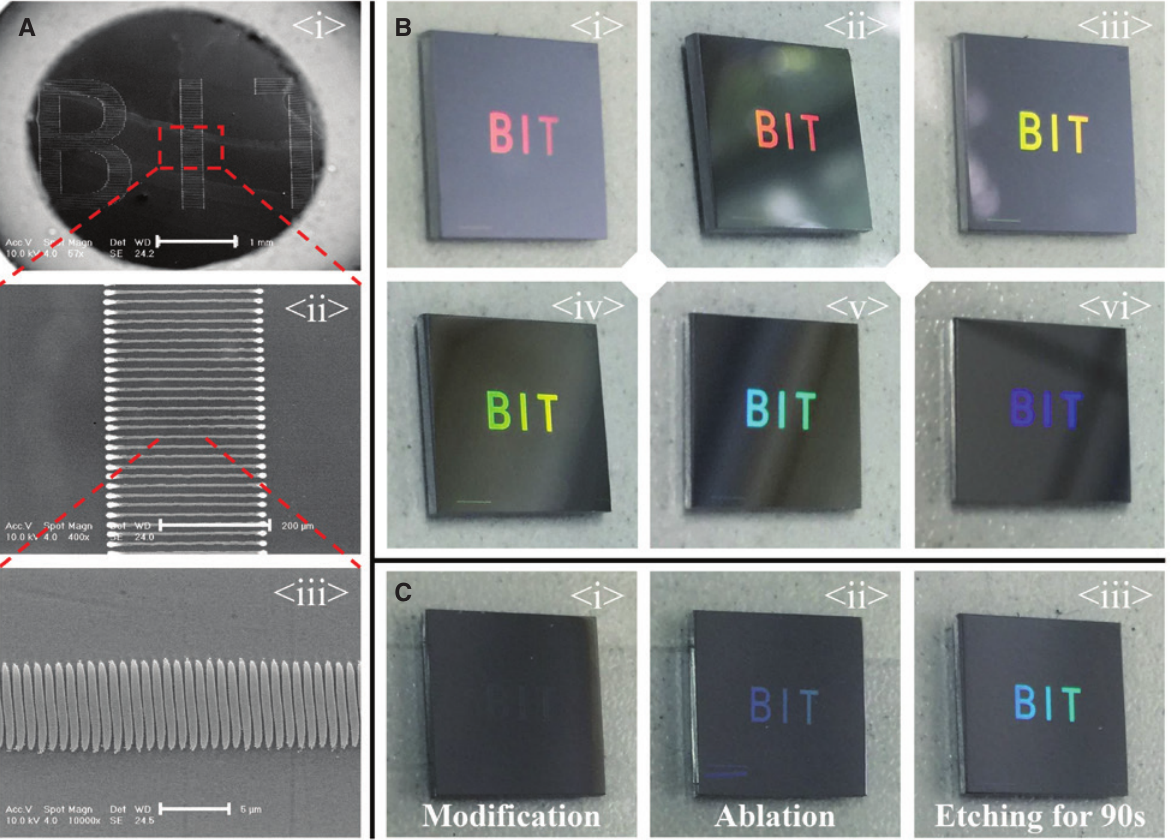
Figure 6: “BIT”-shaped large-area nanograting structures fabricated by chemical etching-assisted femtosecond laser modification, using = 2000 μ m s −1 , and T = 90 s, respectively. F = 167 mJ cm −2 , v scan et (A) SEM micrographs of the fabricated structure. (A < ii > ) and (A < iii > ) are the magnified depictions of (A < i > ). The scales in (A) are 1 mm, 200 μ m, and 5 μ m, respectively. (B) The structural colors of the Si surface with 2D nanograting structures. Gradual changing of the viewing angle leads to the appearance of color red to purple shade due to the chromatic dispersion. (C) The structural colors of the Si surface adopting three different processing methods. A detailed comparison of the structural colors is shown in Videos